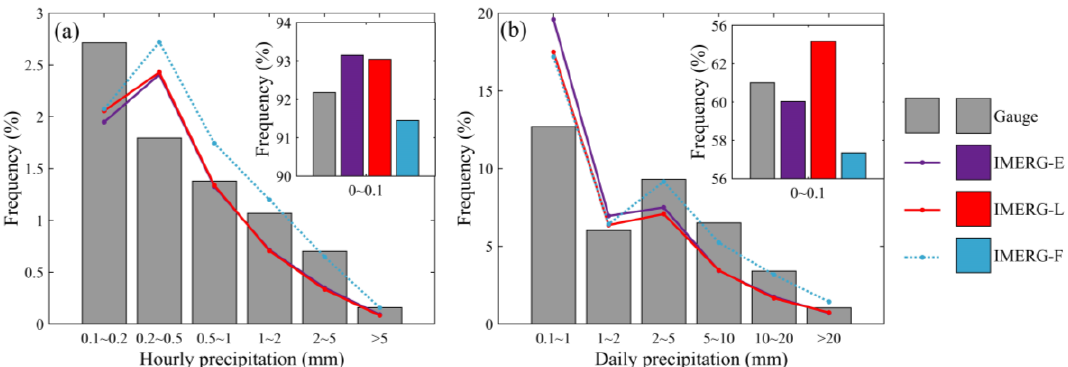
Figure 3. Comparison of the frequency distribution of the IMERG precipitation estimates with those of the ground observations from 1 June 2014 to 31 December 2018: ( a ) hourly and ( b ) daily time scales.